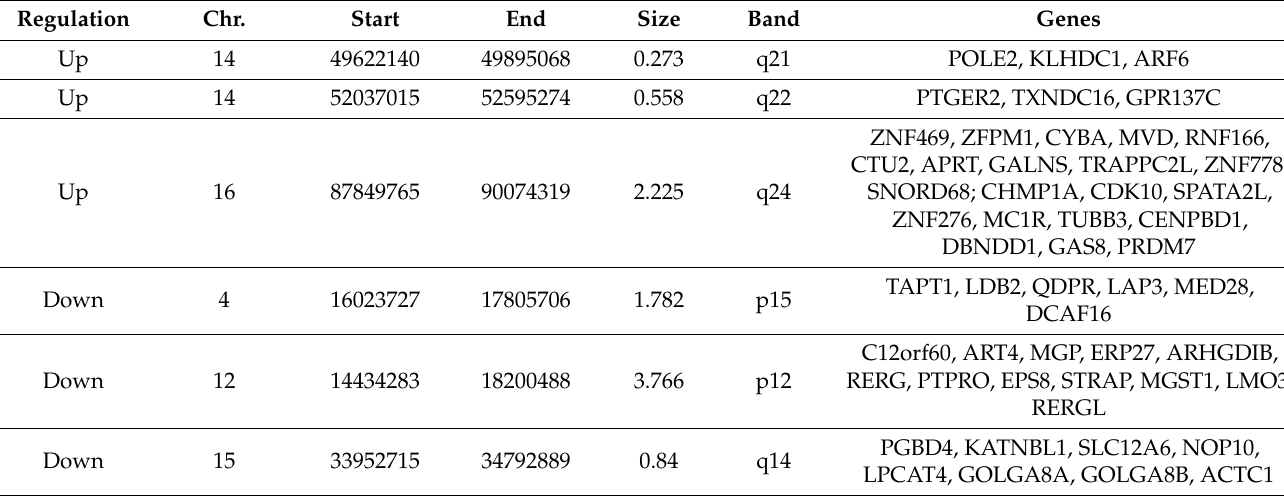
Figure 4. The regional variations of genomic features. ( A ). Amplified (red) and deleted (blue) regions identified by PREDA. ( B ). The biological process classification of genes on chr16q24 (amplified region). ( C ). The biological process classification of genes on chr12p12 (deleted region). Table 2. The regional variations of genomic features of aortic dissection.